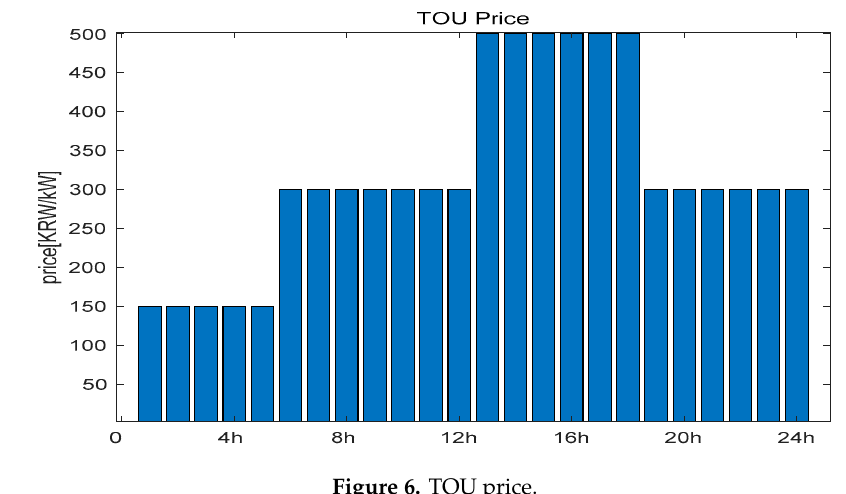
Figure 5. Route from starting point to destination.